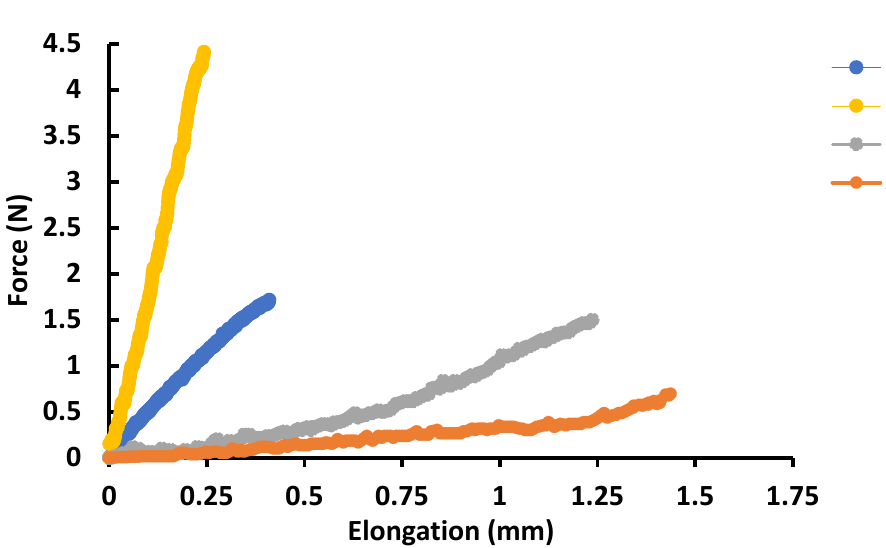
Figure 5. The mechanical analysis of (A) uncrosslinked SF-CS-Ag-CUR (CS 7% w / v ), (B) crosslinked SF-CS-Ag-CUR (CS 7% w / v ), (C) uncrosslinked SF-CS-Ag-CUR (CS 9% w / v ), and (D) crosslinked SF-CS-Ag-CUR (CS 9% w / v ) nanofibers.